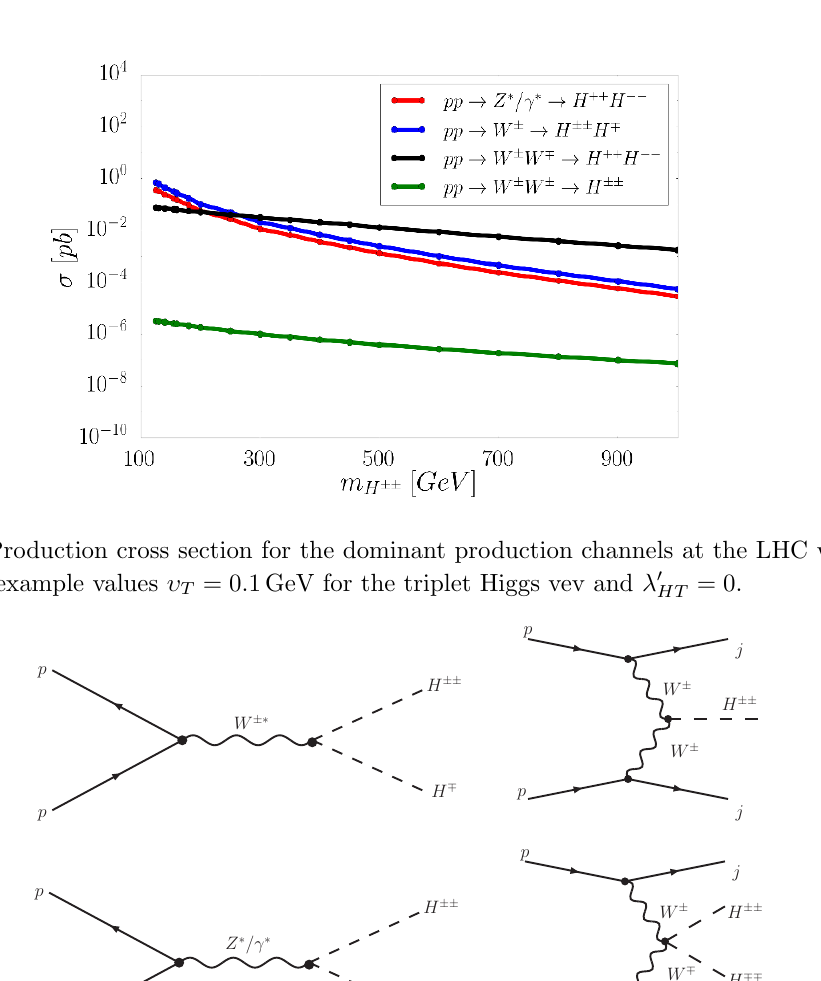
Figure 2 . Dominant Feynman diagrams for the production of doubly charged scalers H (cid:6)(cid:6) (i.e. the doubly charged components of the triplet Higgs (cid:12)eld (cid:1) in the minimal type II seesaw mechanism) via neutral and charged current